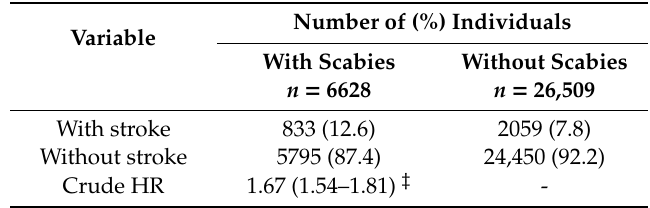
Table 2. Cox regression analysis results regarding the degree to which a past scabies infection is predictive of subsequent stroke versus no such past